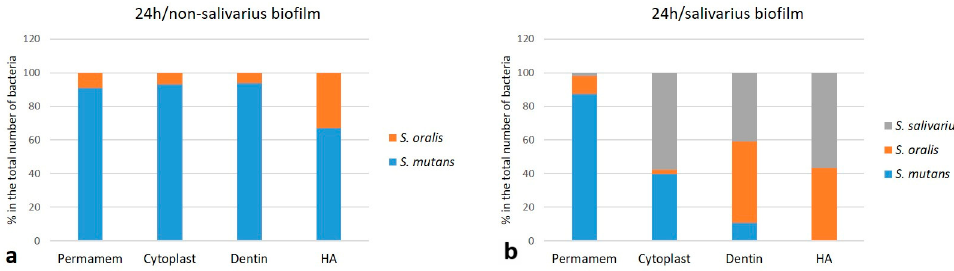
Figure 2. Distribution (%) of individual bacterial species in initial streptococcal biofilm ( n = 9); ( a ) non-salivarius streptococcal mixed biofilm; ( b ) salivarius streptococcal mixed biofilm.